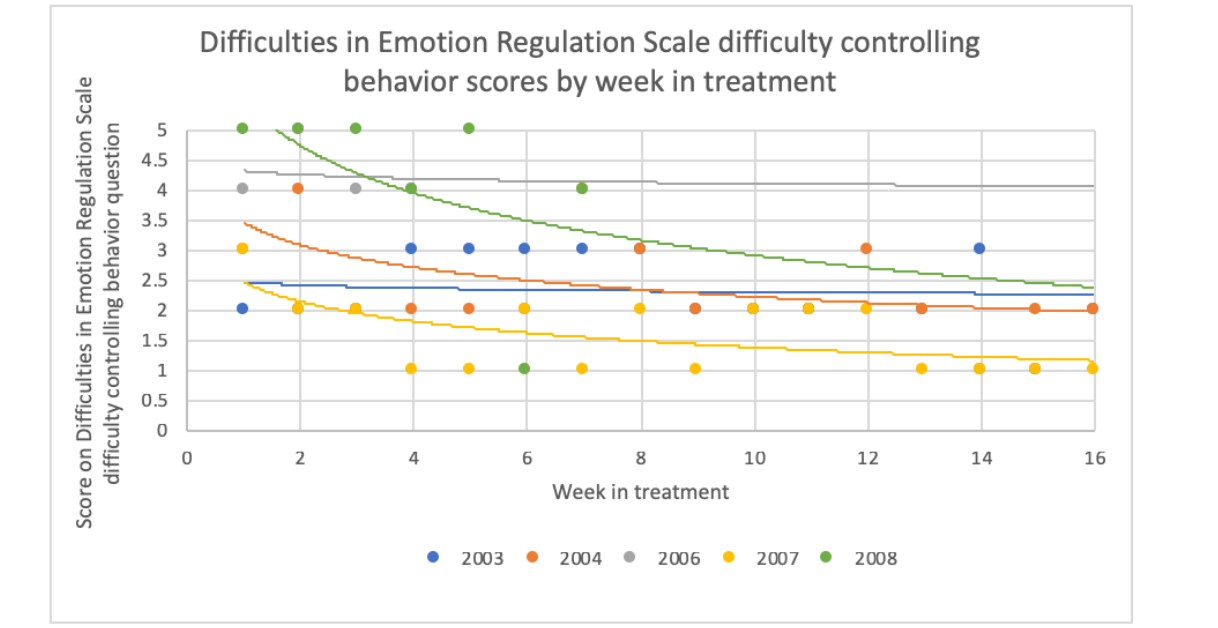
Figure 9. Change in score on the Difficulties in Emotion Regulation Scale item, “When I was upset, I had difficulty controlling my behaviors,” throughout